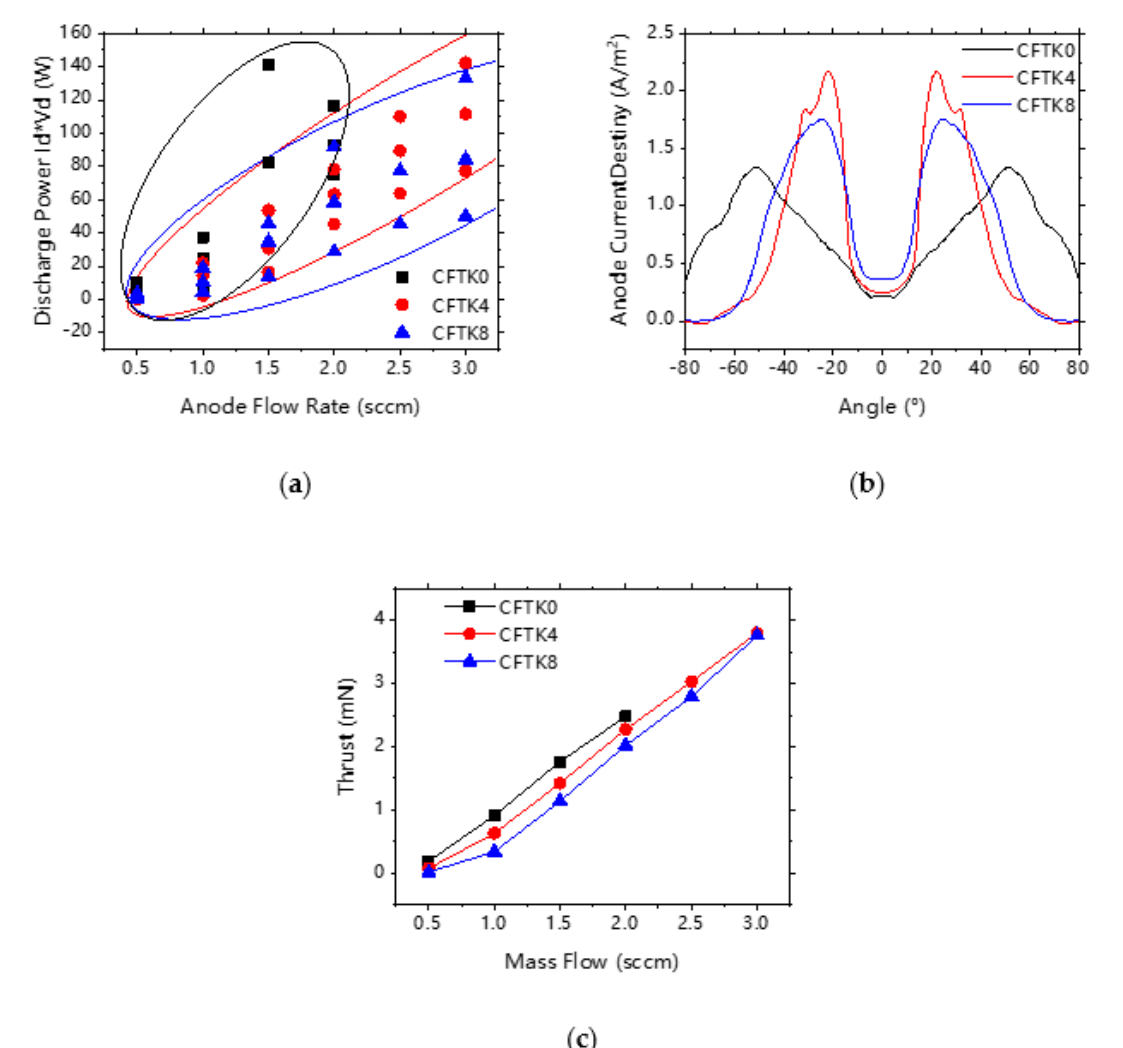
Figure 17. Performance difference of thrusters with different expanding angle configurations; ( a ) Operation space, ( b ) ion current density distribution and ( c ) thrust. CFTK0, 4 and 8 are cusped field thrusters with different channel expanding angles (0°, 4° and 8°, respectively).